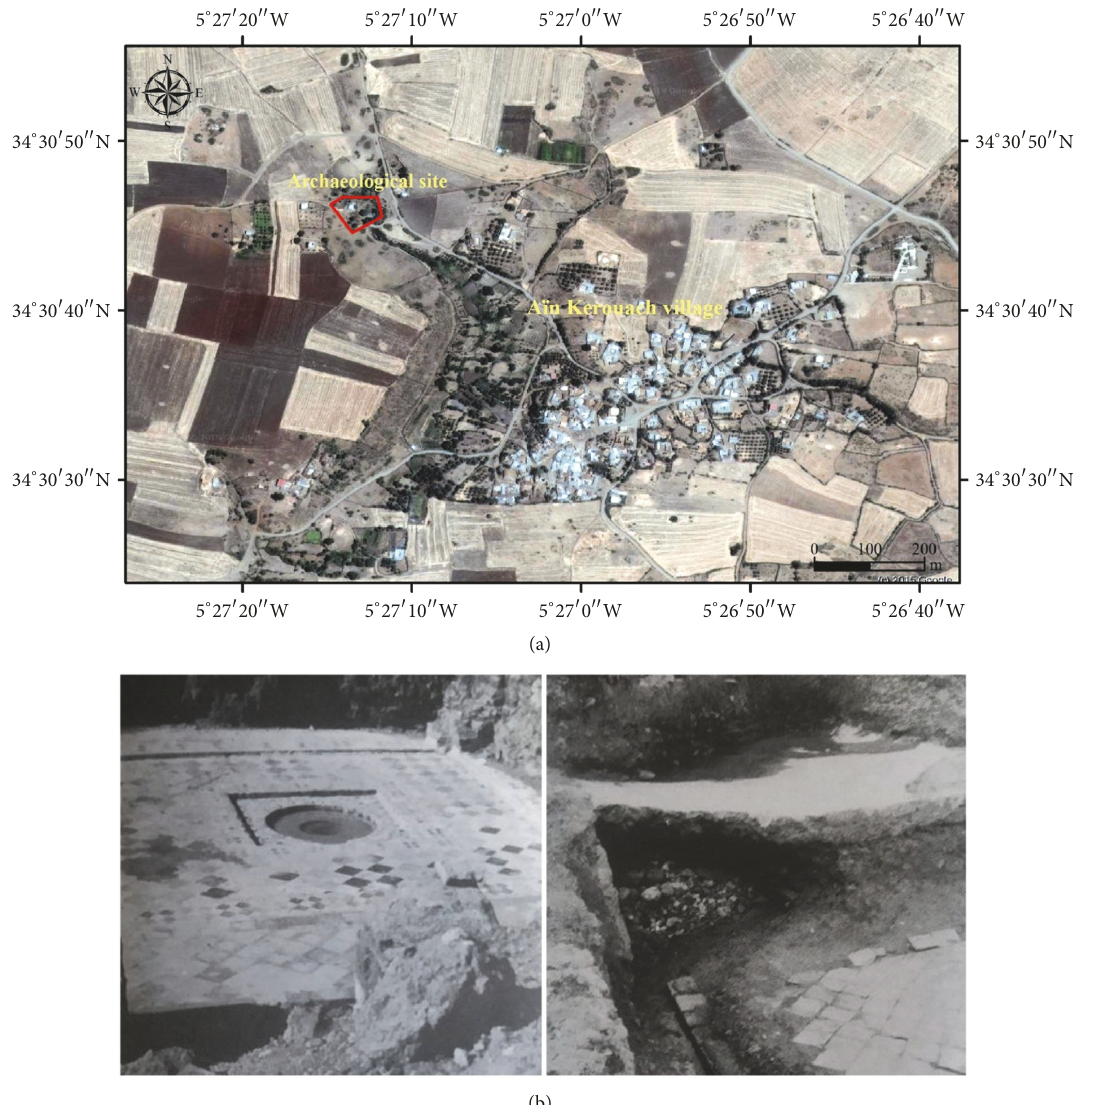
Figure 2: Archaeological site of A¨ın Kerouach: (a) Google Earth (cid:2) view of the archaeological site; (b) photographs of some discovered decorative structures [9].